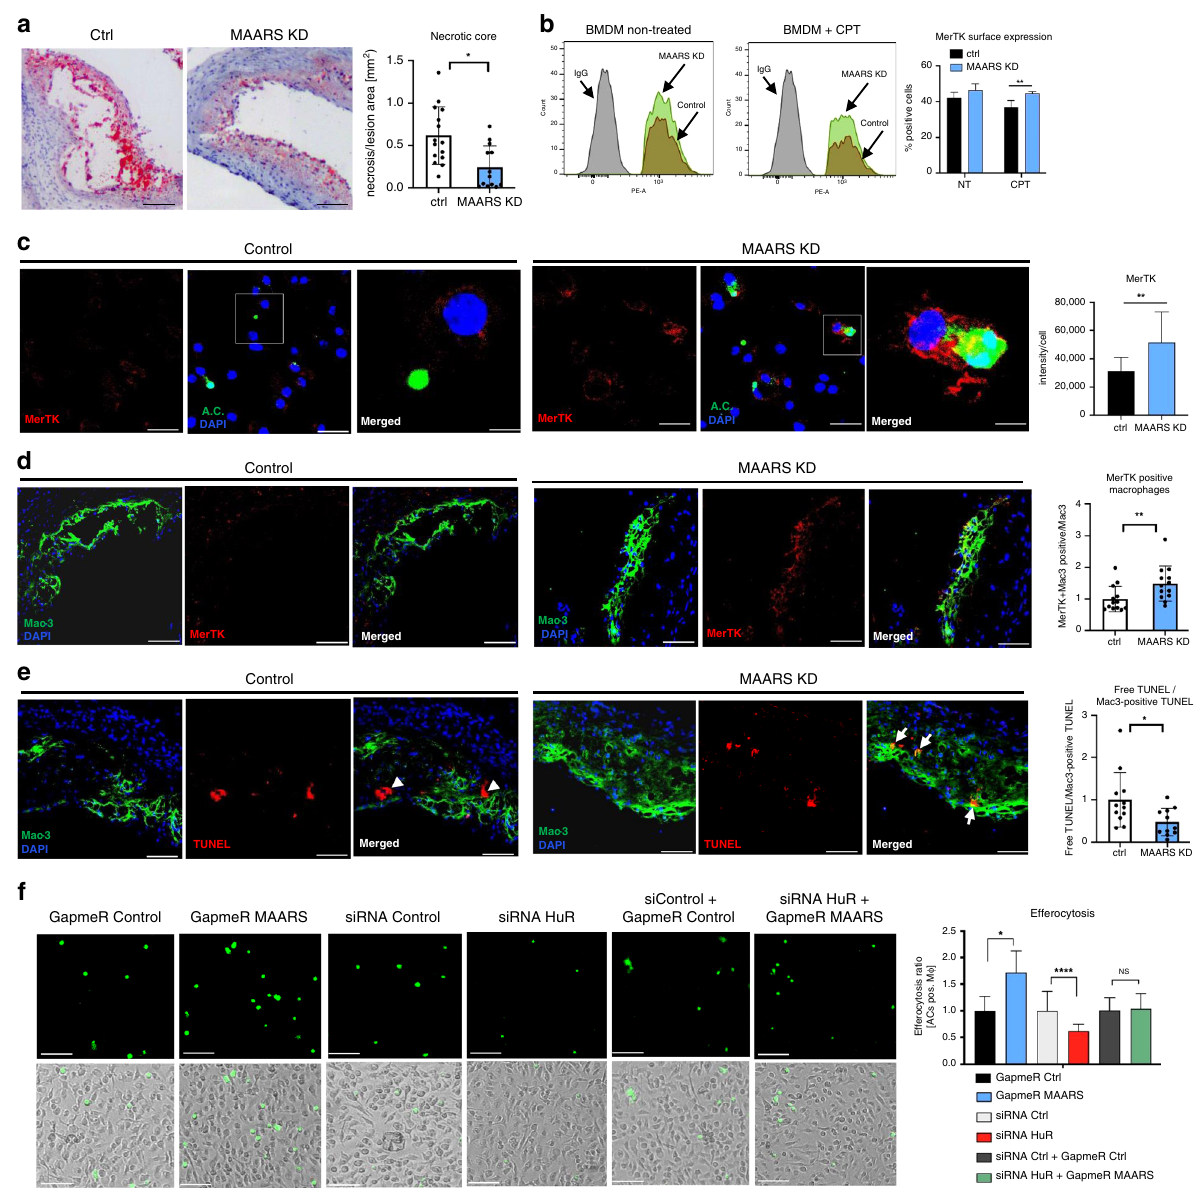
Fig. 6 In vivo knockdown of MAARS inhibits plaque necrosis and increases efferocytosis. a Quanti fi cation of plaque necrosis in the lesions of the aortic sinus of LDLR − / − mice fed HCD treated with control ( n = 15) or MAARS gapmers (knockdown (KD), n = 13). b Flow cytometry staining with the efferocytosis marker MerTK in BMDMs treated with or without 20 µ M CPT for 2 h and incubated with Jurkat apoptotic cells for 1 h at a BMDM:AC ratio of 1:10. c High resolution confocal images and quanti fi cation of MerTK staining in BMDMs treated with 20 µ M CPT for 2 h and incubated with Jurkat apoptotic cells (AC) for 1 h at a BMDM:AC ratio of 1:1. d Evaluation of macrophage efferocytosis in vivo by co-staining with MerTK and Mac-3, and quanti fi cation of the ratio between double-positive MerTK + /Mac3 + and Mac3 staining alone in the aortic sinus of LDLR − / − mice fed HCD treated with control ( n = 15) or MAARS gapmers (KD, n = 13). e Quanti fi cation of the ratio between free TUNEL staining (arrow heads) vs. Mac3-positive TUNEL staining (arrows), re fl ecting Mac3-positive efferocytotic macrophages, in the aortic sinus lesions LDLR − / − mice fed HCD treated with control ( n = 15) or MAARS gapmeRs (KD, n = 13). f In vitro efferocytosis assay: BMDMs were transfected with control or MAARS gapmeRs in the presence or absence of the indicated control or HuR siRNAs and subsequently incubated with calcein AM-labeled apoptotic Jurkat cells for 1 h. Efferocytosis was quanti fi ed as the ratio of calcein- positive (<3 µ m) vs. calcein-negative macrophages ( n = 3, quanti fi cation of at least 20 images per condition). For all panels, values are mean ± SD; * p < 0.05; ** p < 0.01; *** p < 0.001; **** p < 0.0001; **** p < 0.00001. the MAARS silencing was already achieved (~90%) in BMDMs protects mice from endotoxemia-induced fatality, but is itself (Supplementary Fig. 5e, f), hence the potential MAARS down- increased in response to in fl ammatory stimuli 60 . While we have regulation after the addition of CPT and TNF- α was likely neg- not identi fi ed a negative feedback mechanism for MAARS , we ligible. Moreover, the MAARS binding af fi nity to HuR is not cannot rule out the existence of such mechanism in response to stress induced by apoptotic stimuli. Importantly, in all our affected by CPT or TNF- α treatments in BMDMs, as observed in experiments the CPT and TNF- α were added to the cells when the pulldown experiments (Supplementary Fig. 5g). NATURE COMMUNICATIONS| (2020) 11:6135